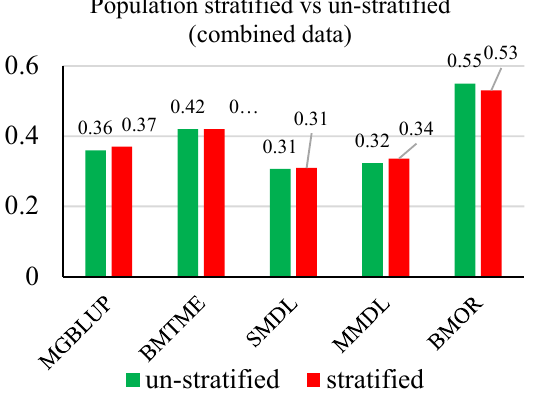
Figure 5. Average prediction accuracies for combined data with / without population stratified for five models Mean Pearson’s correlations for each trait were presented and labeled. The stratified scheme was colored in green, and the un ‐ stratified scheme was colored in red.